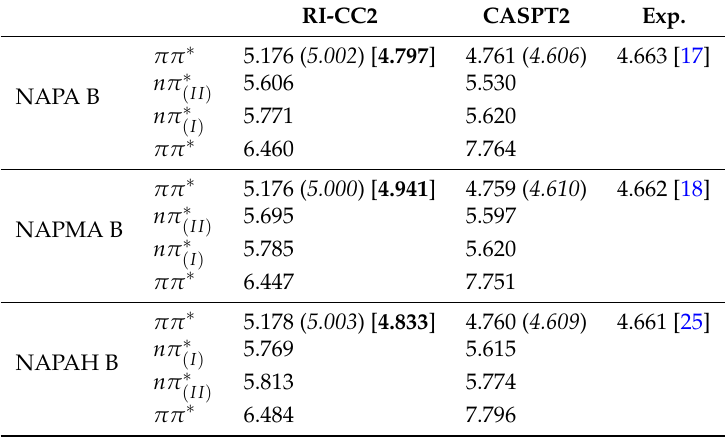
Vertical absorption energies to the four lowest excited singlet states of conformers NAPA B, NAMPA B and NAPAH B, computed at the RI-CC2/cc-pVDZand MS-CASPT2/SA- CASSCF(14,12)/cc-pVDZ levels. The ground state minimum structures were optimized at the RI-CC2/cc-pVDZ level of theory. ( Adiabatic ) and [ nuclear zero point energy corrected adiabatic ] transitions are given. The RI-CC2/cc-pVDZ method was used for the geometrical optimization of the first excited state structures, as well as for the calculation of the Hessian matrix in the ground and first excited state. All values are in